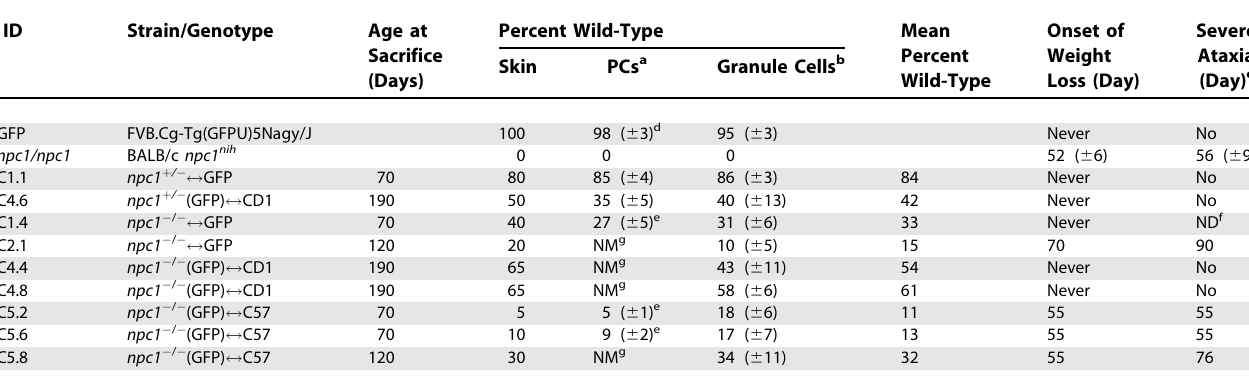
Table 1. Genotype and Percentage Chimerism for the Mice Used in This Study ID